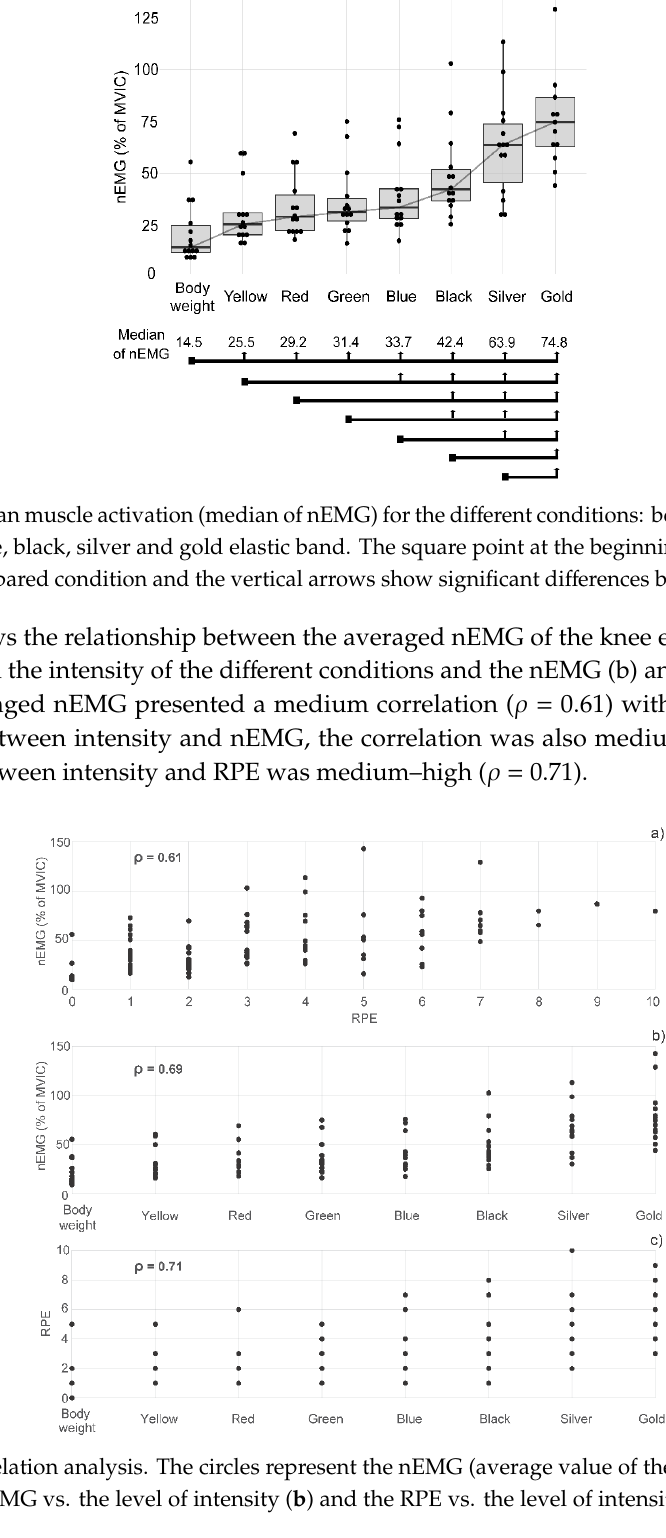
Figure 7. Percentage of intensity-related pain for every condition. The majority of patients found all the conditions to be “very well tolerated” or “tolerated”. Only one participant did not tolerate the silver band. Figure 8 shows tolerability percentages.